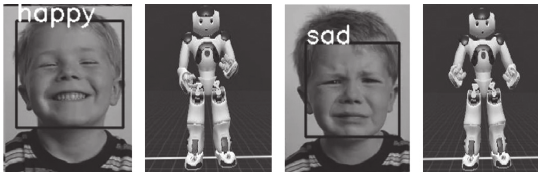
Figure 8: The emotional interaction results.